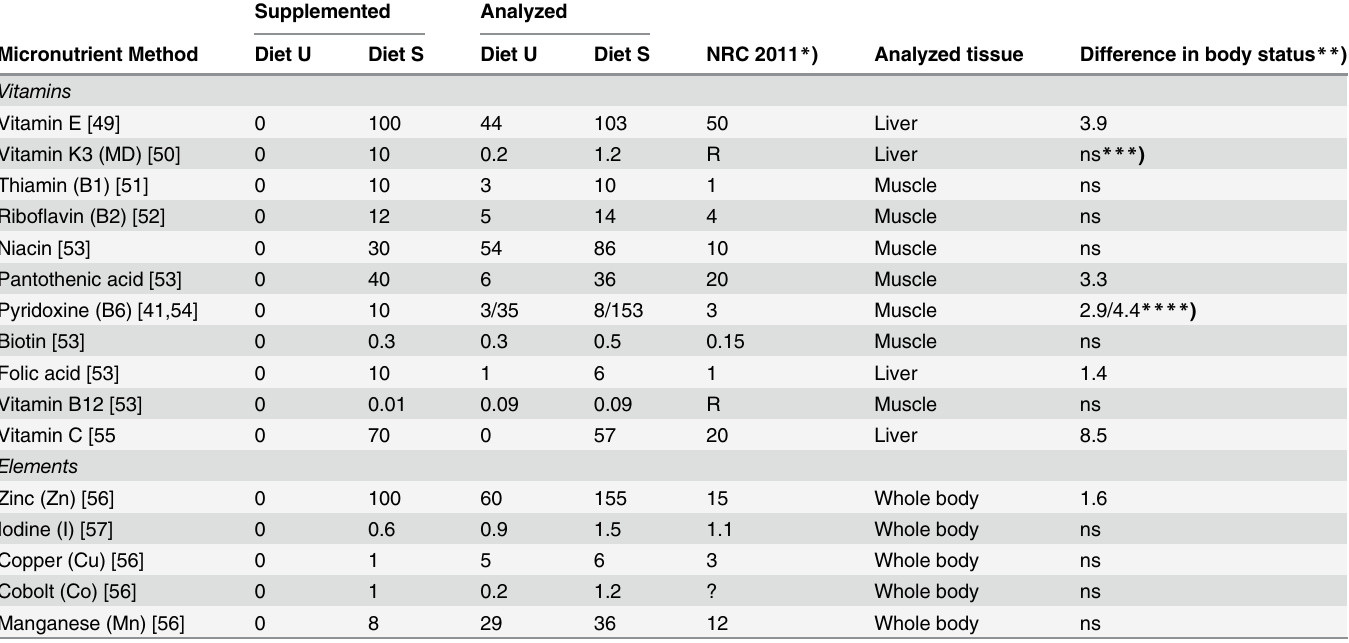
Table 2. Target supplementations of vitamins and minerals (mg kg -1 ) from the premix in the two experimental diets (unsupplemented Diet U and supplemented Diet S), respective analyzed feed values, present nutrient requirements from the NRC (2011), and significant changes in respective tissue status between the dietary